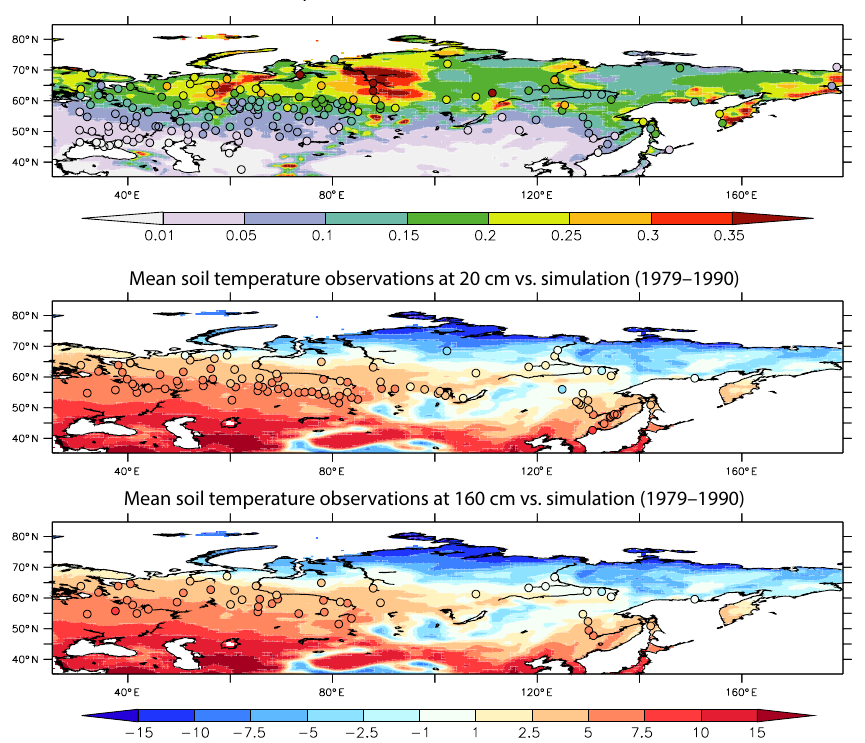
Figure 7. Quantitative comparison between observed (plain circles) and simulated (plain fields) daily snow depth and monthly soil temper- ature at 20 and 160cm depths over northern Eurasia. Only the results from the bare soil sub-grid patch of the NEW-SOC simulation are presented because in situ measurements have been collected in open areas following the WMO standards as mentioned in Sect.